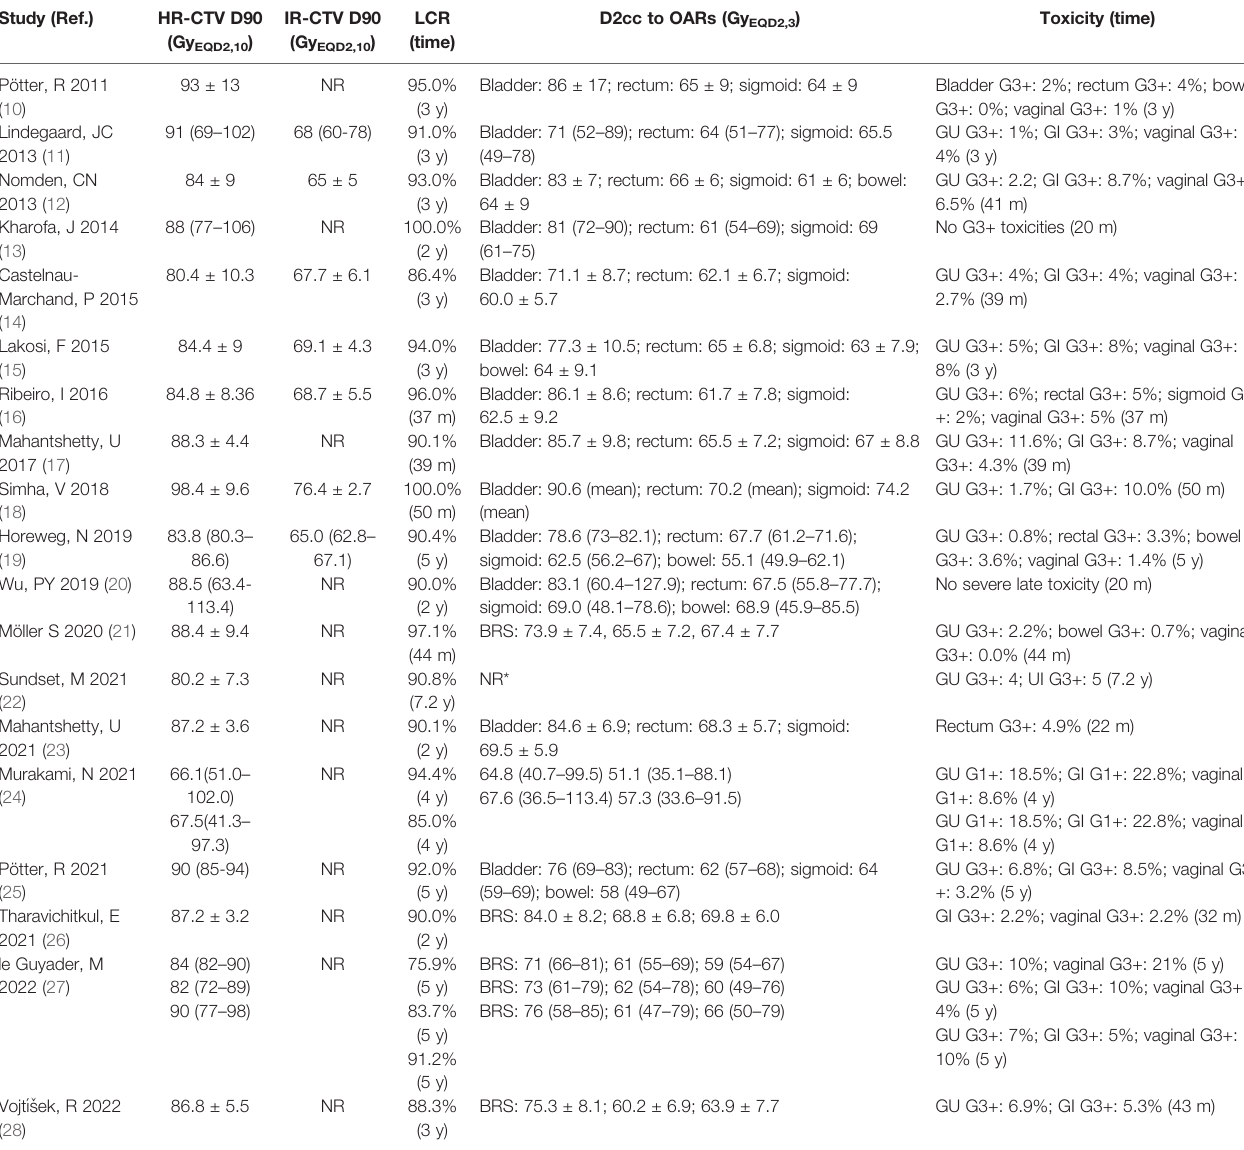
TABLE 2 | Main characteristics of the included studies: dose volume parameters and tumor control. Study